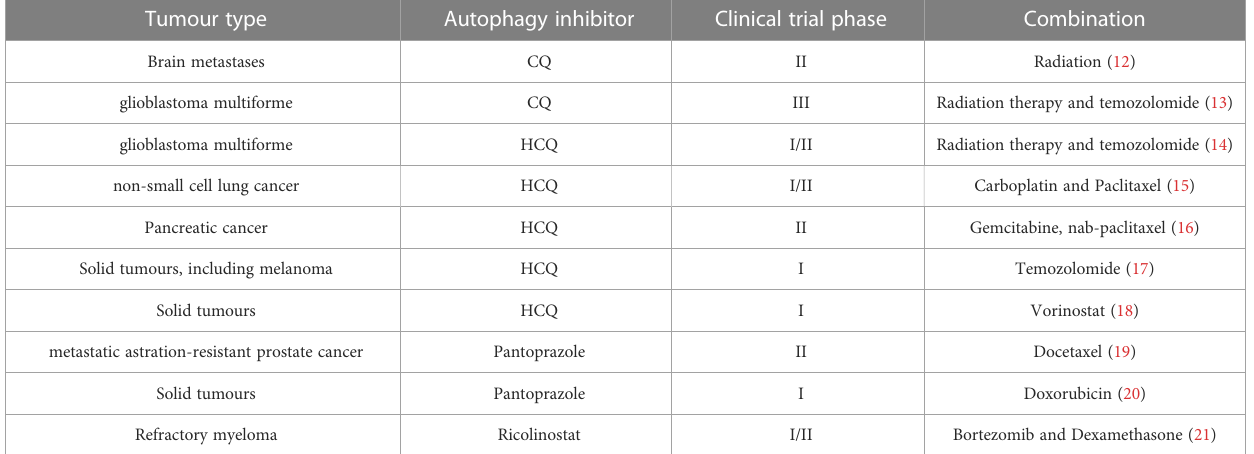
TABLE 1 Clinical strategy of targeted autophagy in tumor